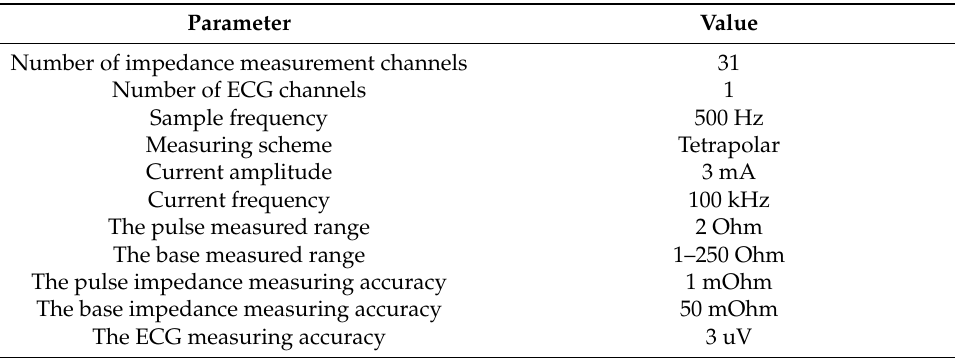
Table 2. The technical specification of Reo-32.